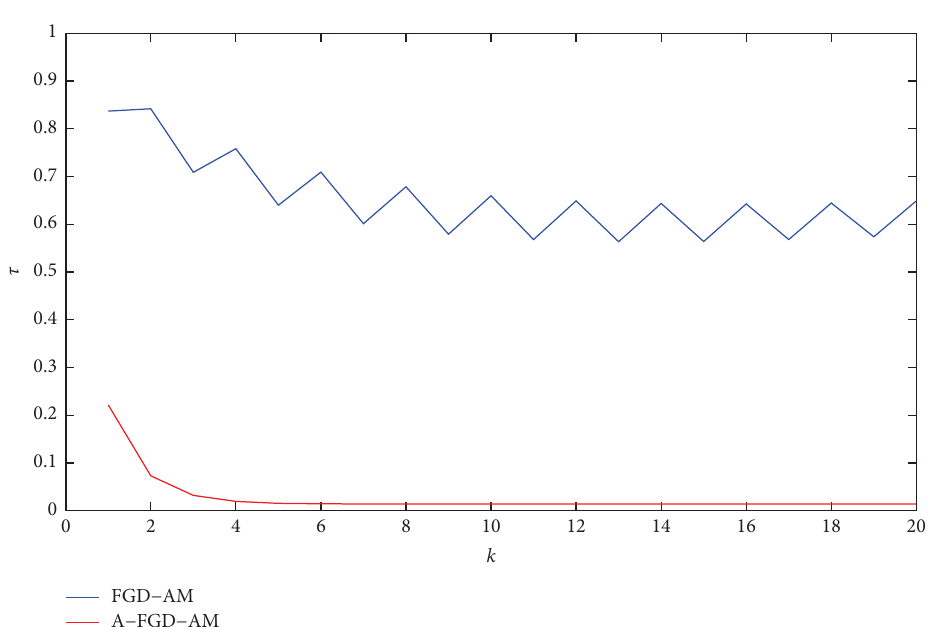
Figure 7: Te parameter estimation errors ( c � 2 . 01/ λ